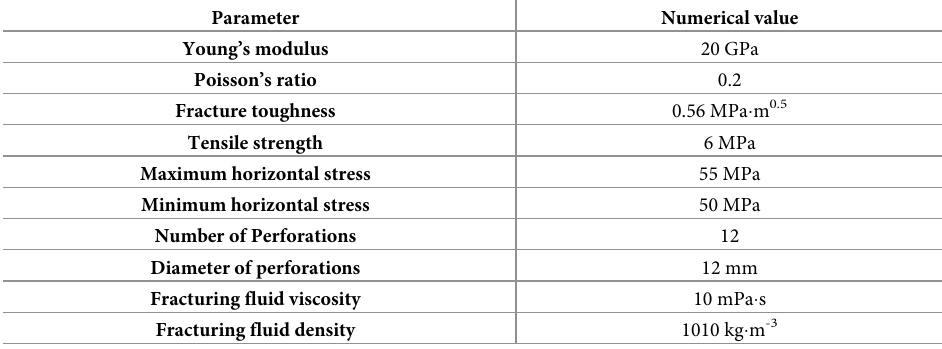
Table 1. Calculation model materials parameter